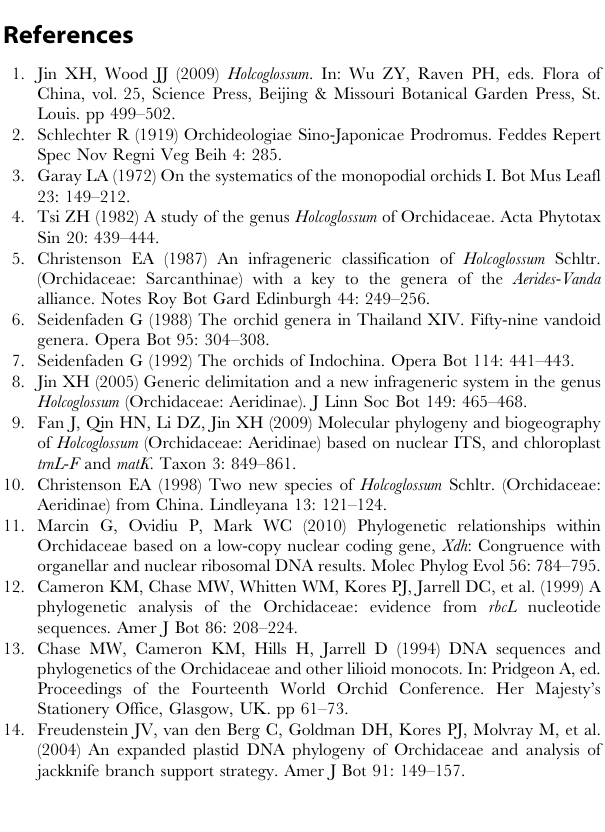
Figure S18 Alignment of trnL-F : sites 856–930 . The species name suffix with ‘‘DL’’ mean the sequences originate from Fan’s paper. Figure S19 Holcoglossum . a–c. H. quasipinifolium (genus and